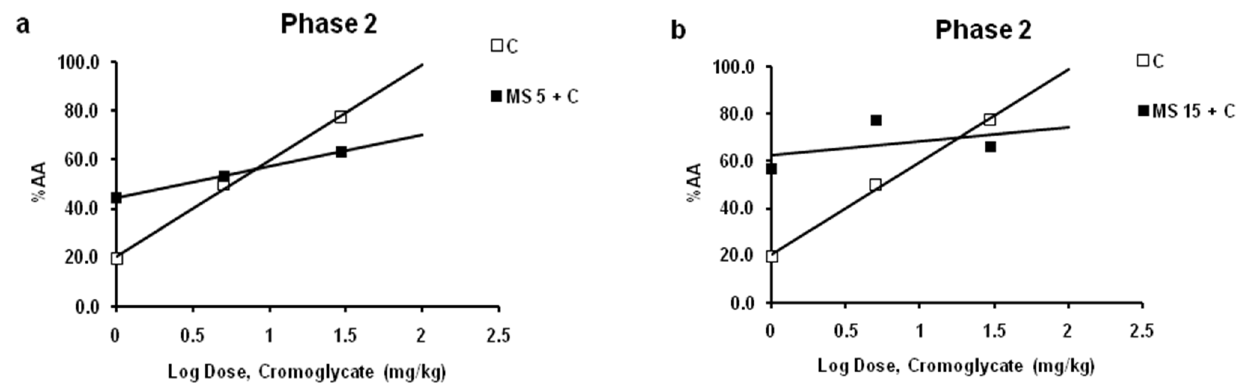
Figure 5. Interaction between cromoglycate (CG) and magnesium sulfate (MS) in phase 2 of for- malin test. Log dose–response for CG (1, 10, and 30 mg/kg; sc) alone and in the combination with MS (5 mg/kg) ( a ) or MS (15 mg/kg) ( b ) in phase 2. Data are expressed as a percent of antinociception (AA (%)).